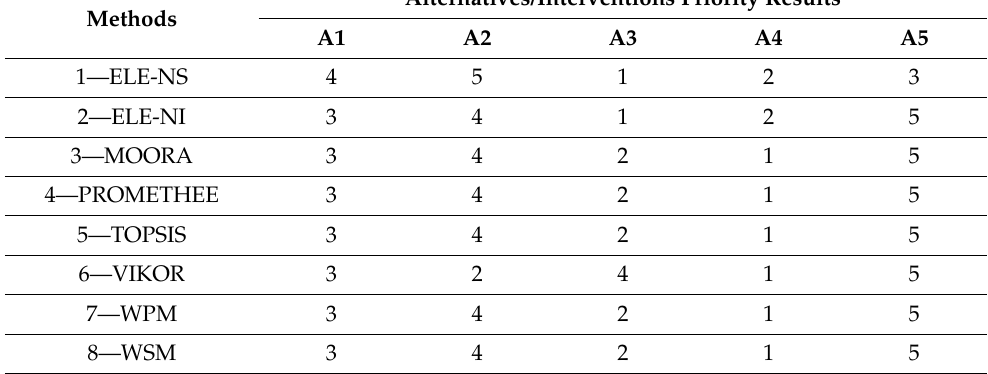
Table 7. Rank calculated by